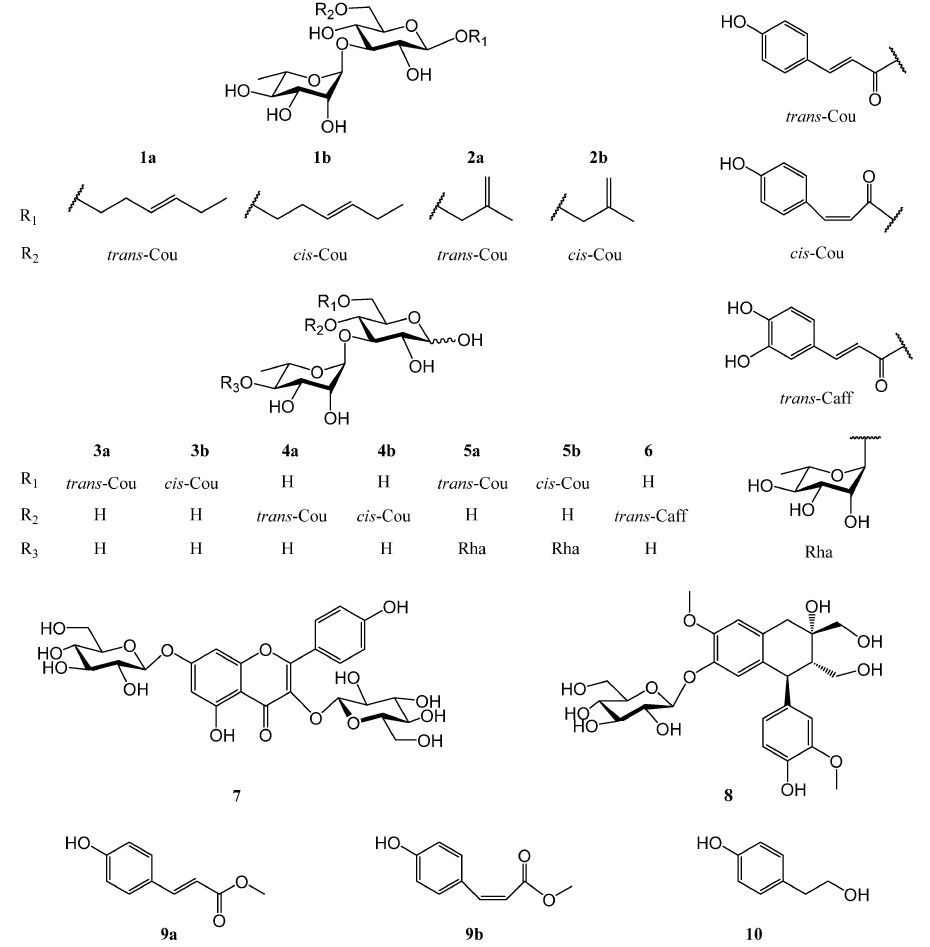
Figure 1. Structures of compounds 1 – 10 from the leaves of L. robustum